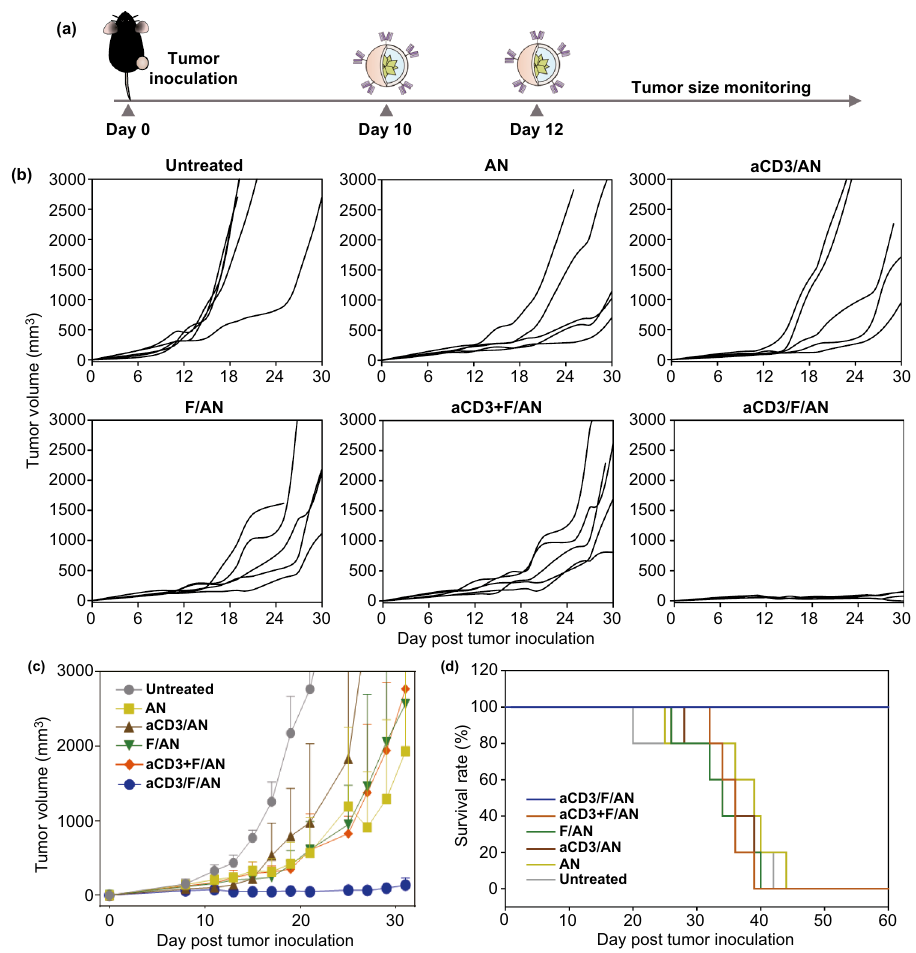
Fig. 10 Antitumor effects of aCD3/F/ANs in vivo. a B16F10 tumor‑bearing mice were intratumorally injected with various nanoparticle prepa‑ rations on days 10 and 12 after tumor inoculation. b, c Antitumor efficacy, determined by measuring tumor volume. d Survival rate in each mouse group, monitored for 60 days after tumor